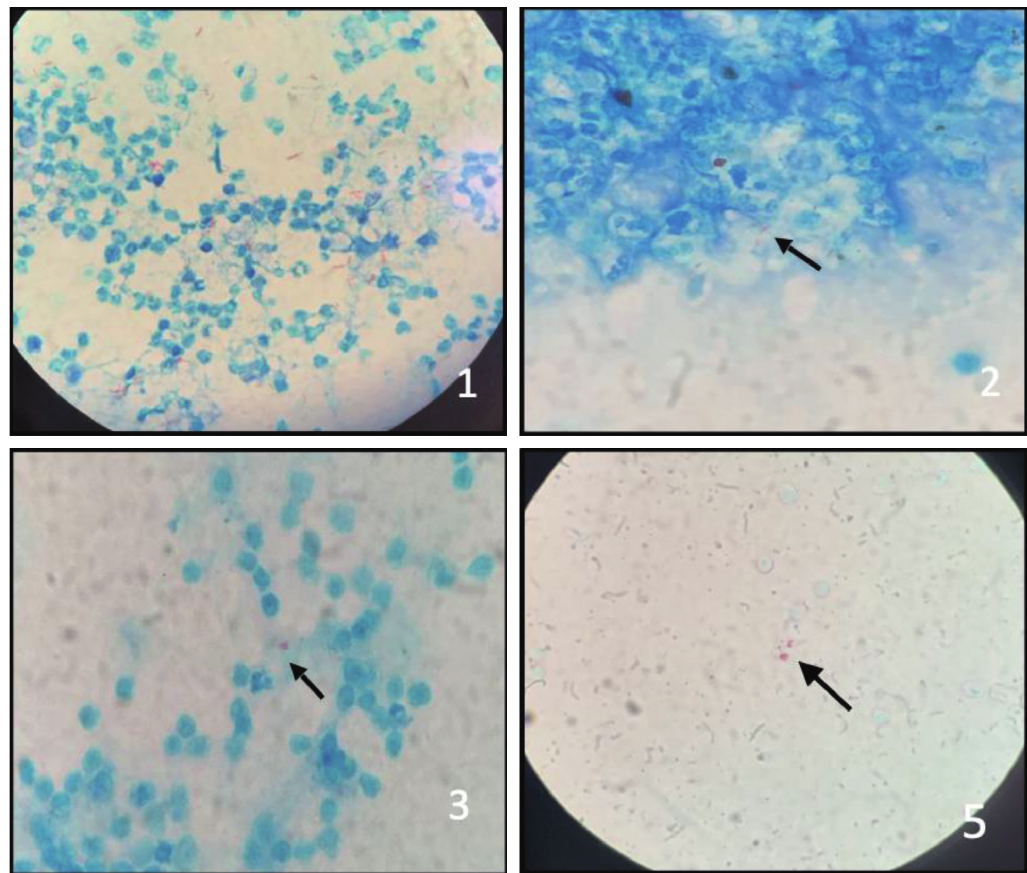
Figure 2: AFB staining slides, Ziehl–Neelsen technique, in CSF, optical microscope, 1000x. (a) Mycobacterium tuberculosis . (b) There was no growth. Arrows indicate the stained bacillus. Source: HUJBB laboratory